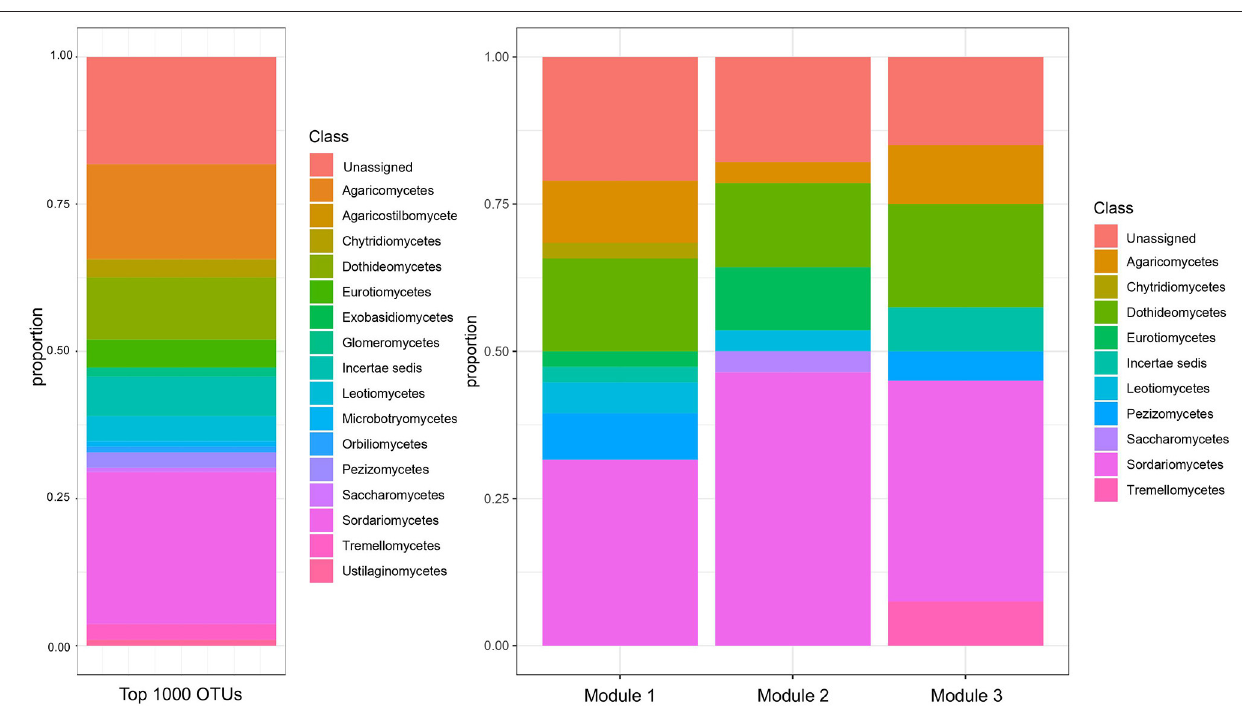
of site and year. For the fungal OTUs, module 1 was very strongly influenced by PrariErth farm and module two by the year 2016.